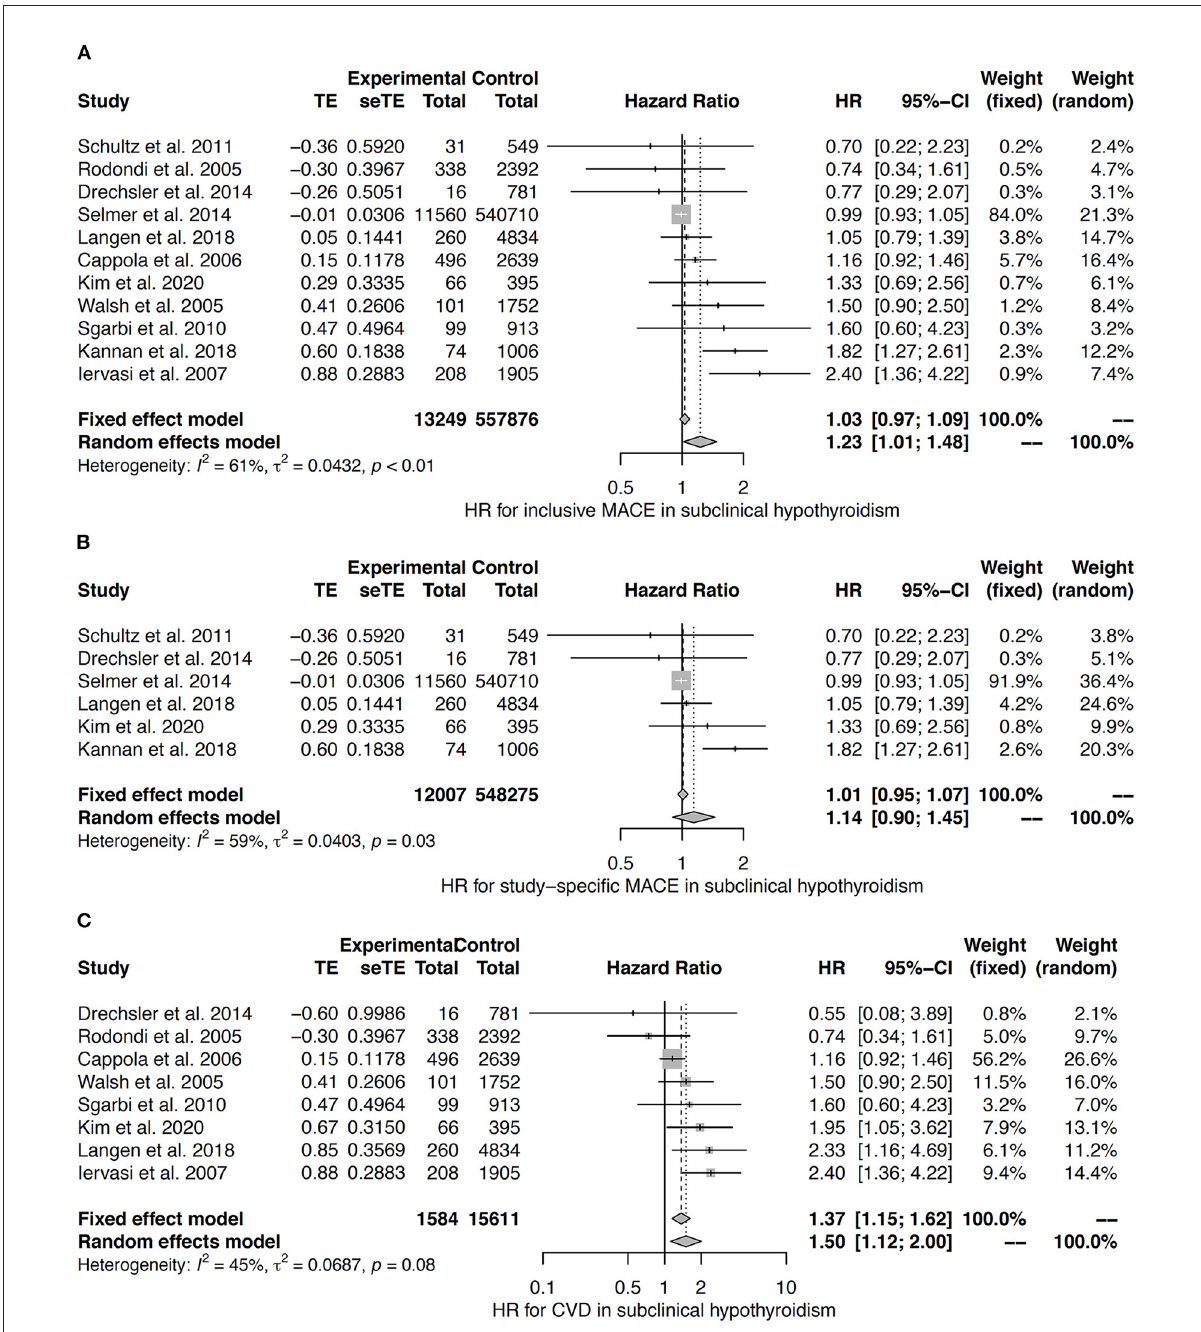
FIGURE8 HR for inclusive MACE (A) , study-specific MACE (B) , and CVD (C) in subclinical hypothyroidism (42, 121, 123, 126, 130, 131, 136, 140–143).